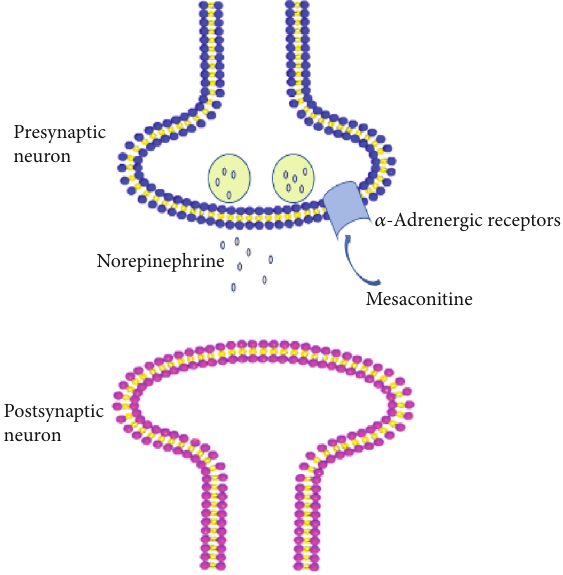
Figure 3: Schematic drawing of the antiepileptiform mechanism of mesaconitine on a noradrenergic neuron in the pyramidal stratum of the